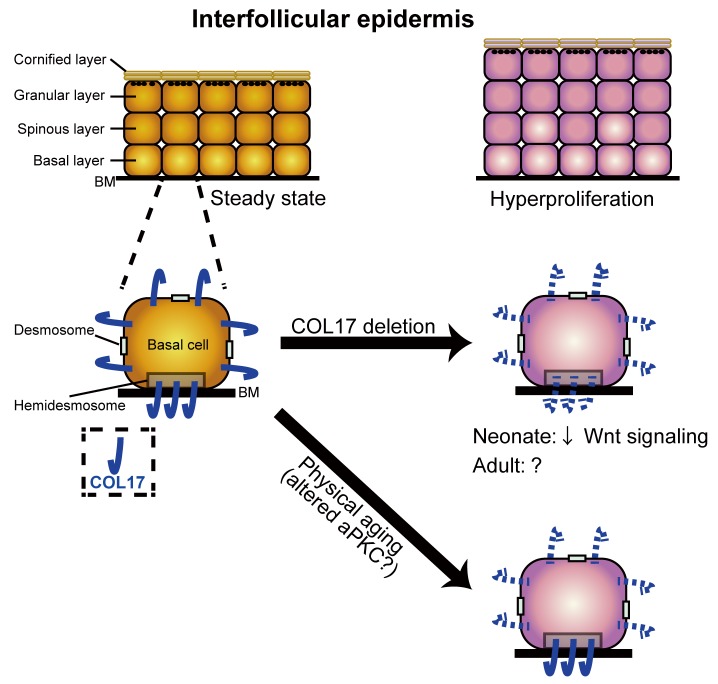
A model of the role of COL17 in maintaining IFE homeostasis.A graphical abstract of this study. COL17 regulates paw IFE homeostasis in coordination with Wnt signaling at the neonatal stage. Physical aging diminishes non-hemidesmosomal COL17 labeling in IFE keratinocytes, leading to IFE hyperproliferation, associated with altered aPKC activities.